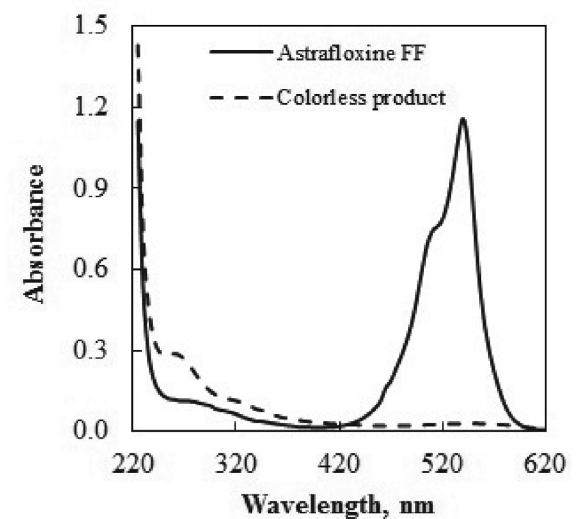
Fig. 2 . The absorption spectra of astrafloxine FF dye and a product of its decolorisation, C astrafloxine FF = 1 × 10 –5 mol L –1 ; C CNS - = 2 ×